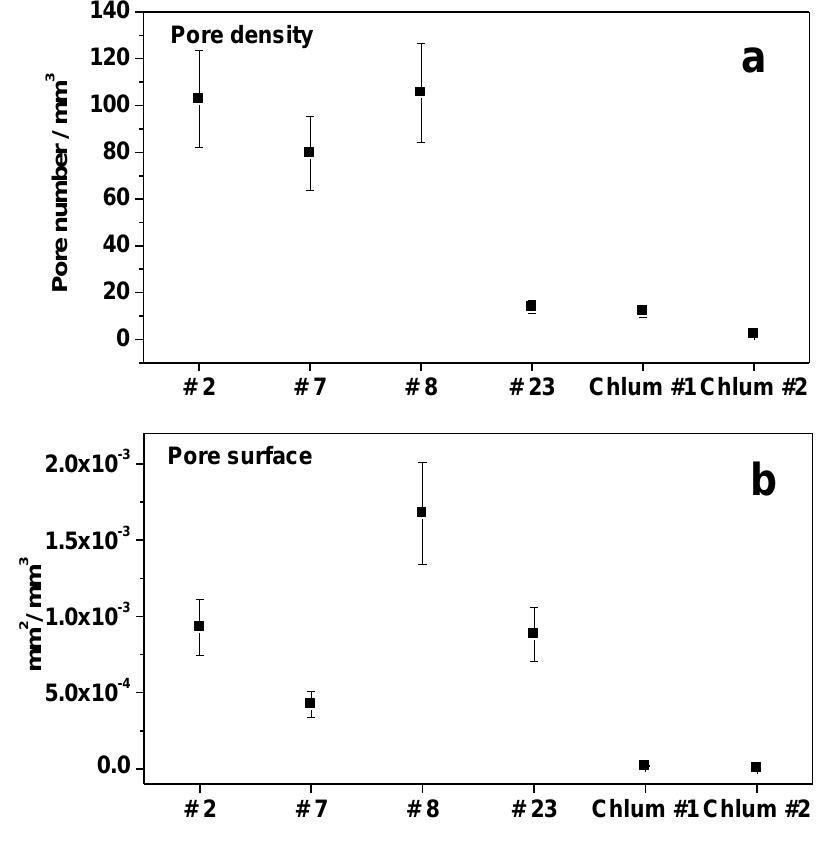
Figure 6. ( a ) Pore density (number of pores per mm 3 ) and ( b ) pore surface density of the investigated samples. Error bars